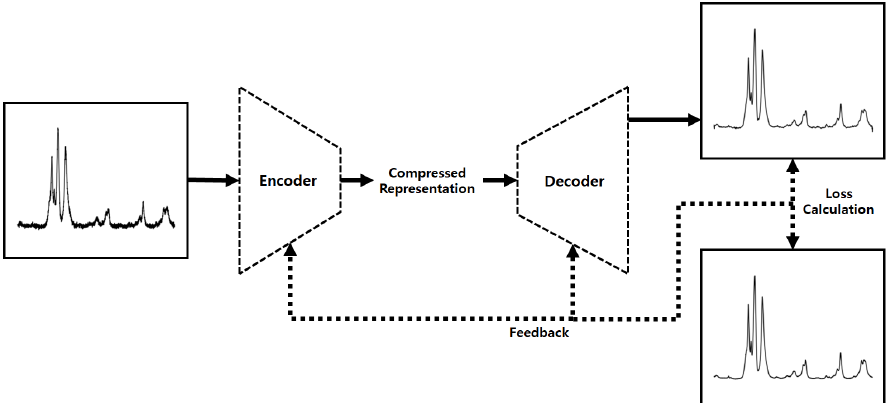
Figure 3. The second training process in the proposed